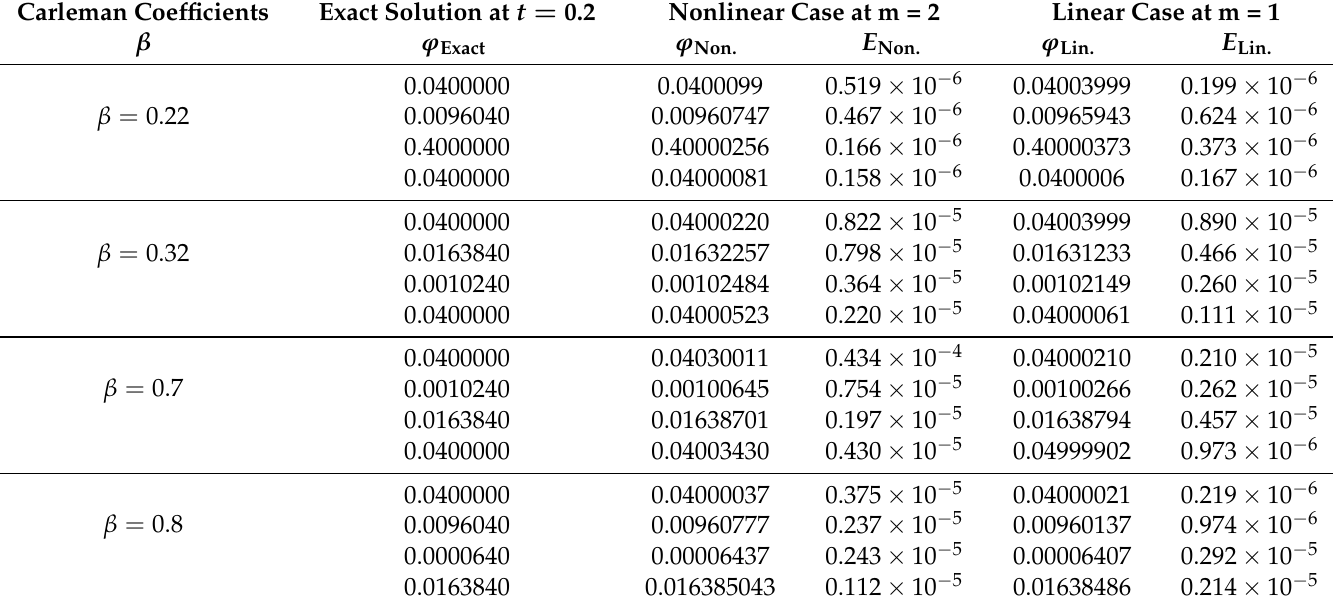
Table 3. Shows the nonlinear and linear cases for Equation (44) for different values of Carleman coefficients at time t = 0.2, N =